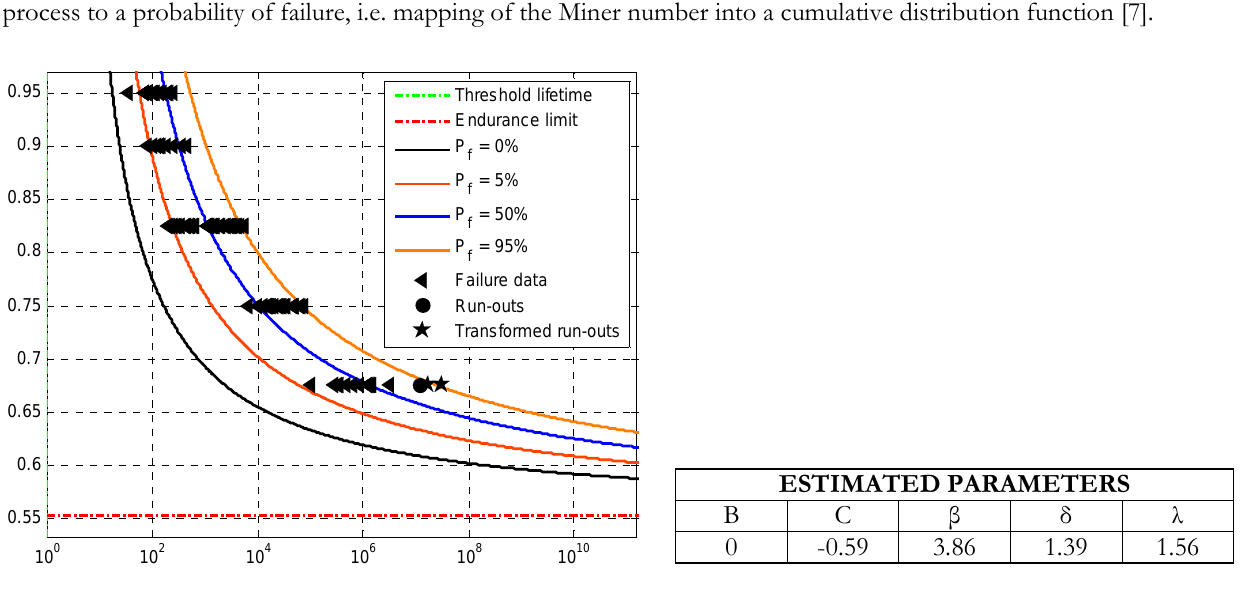
Figure 5: Weibull S-N field with estimated parameters derived from Holmen’s constant stress range concrete tests using the probabilistic fatigue model from